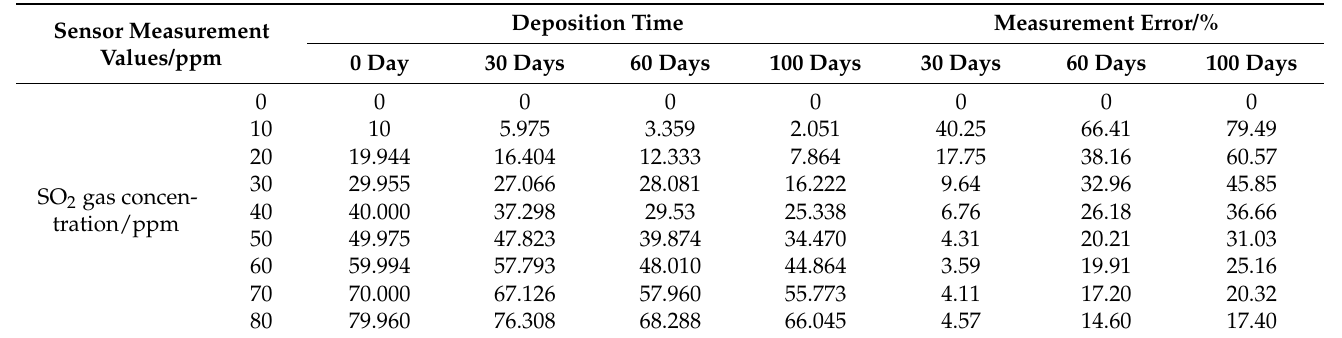
Table 4. Sensor measurements for different concentrations of SO 2 gas at different deposition times.